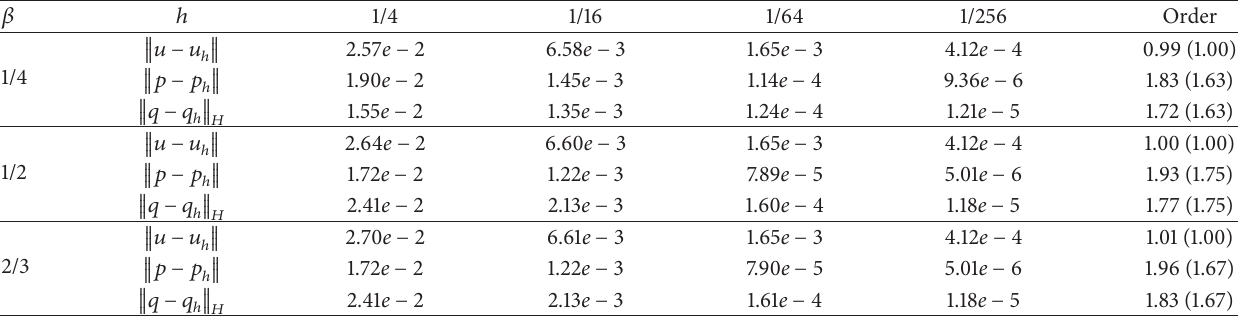
Table 1: Numerical result of Example 1 on a uniform mesh of size ℎ for 𝑘 = 1 .